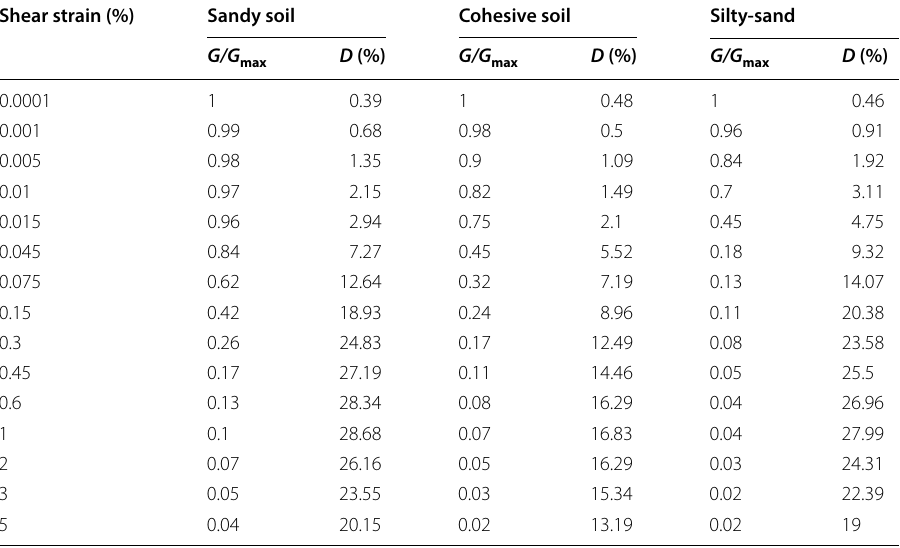
Table 3 Average of G/G and D values at different γ for sand, cohesive soil and silty-sand max Shear strain